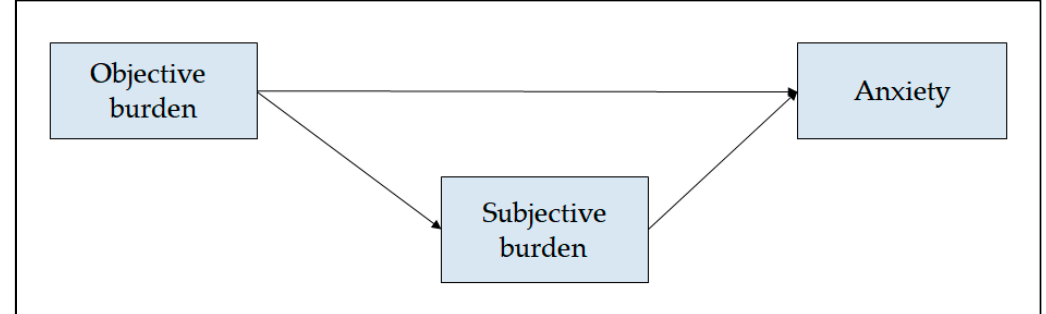
Figure 1. Conceptual model.